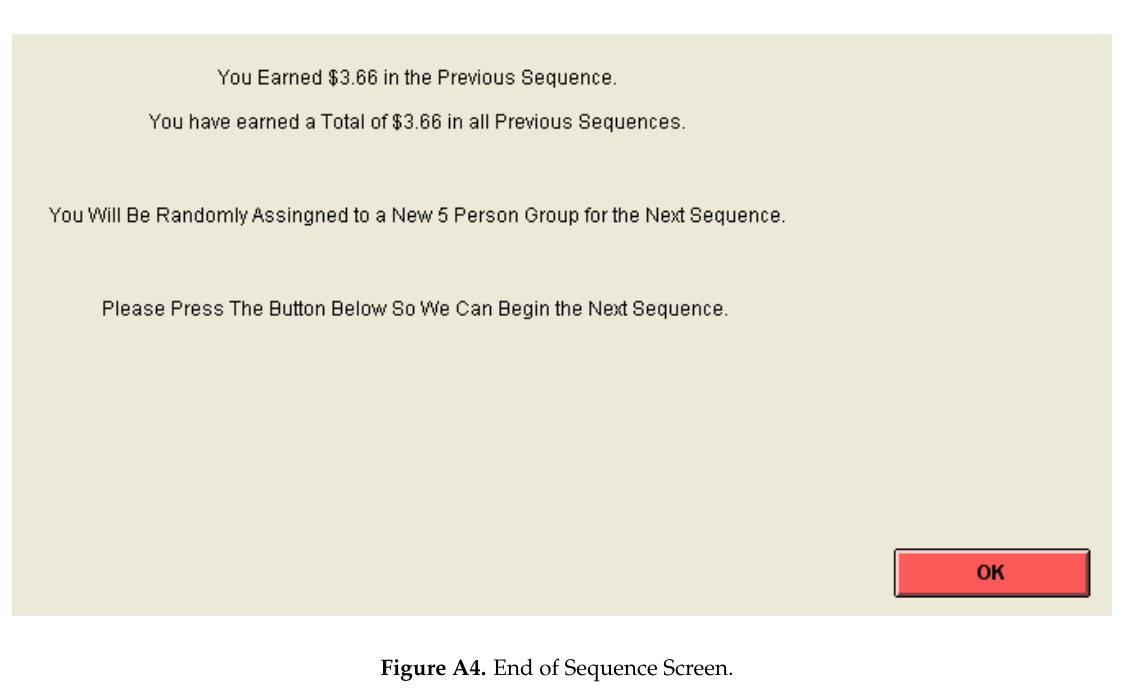
Figure A4: End of Sequence Screen. Figure A4. End of Sequence